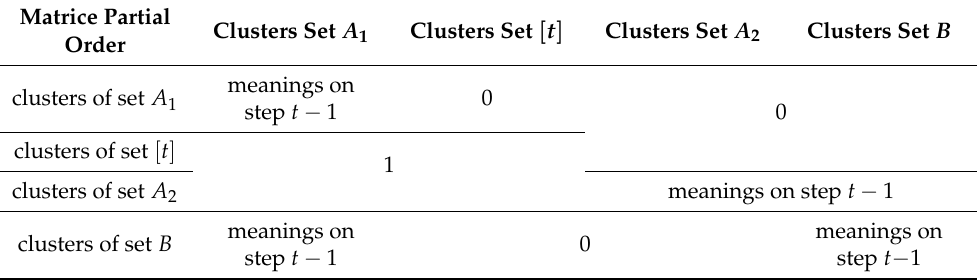
Figure 6. The algorithm of transition from step t − 1 to step t for clusters. Table 1. Algorithm of transition from step t − 1 to step t for a matrix of partial order a